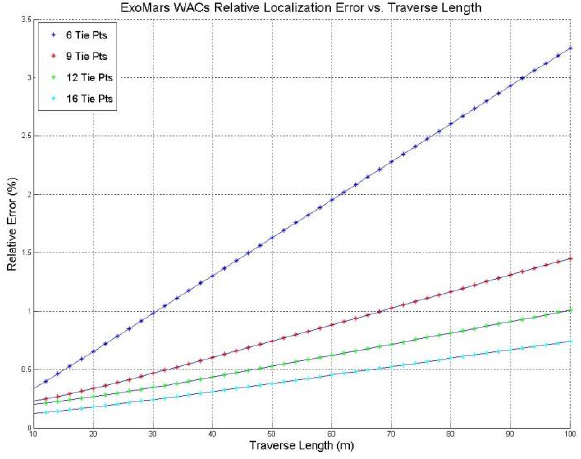
Figure 5. Relative localization error vs. traverse